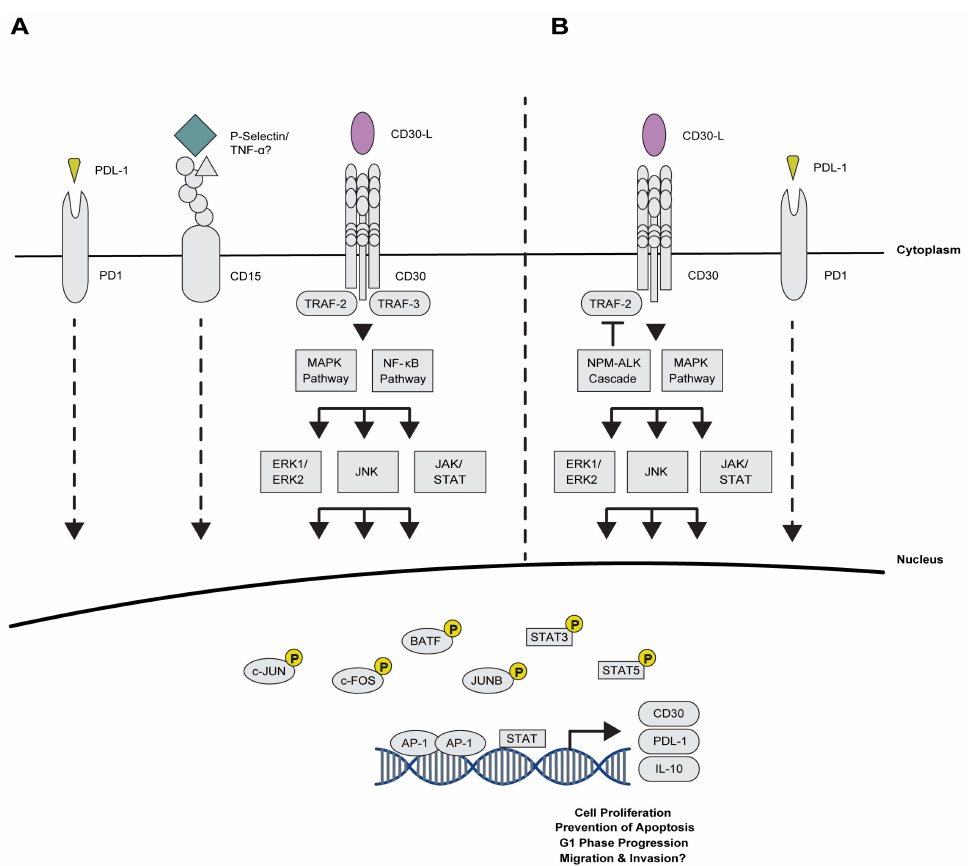
Figure 3. The intricate relationship between CD30 and AP-1 in Classical Hodgkin Lymphoma (CHL) and Anaplastic Large Cell Lymphoma (ALCL). ( A ) Cell surface protein signalling involved in CHL. In CHL, the PD-L1 enhancer binds AP-1 TFs resulting in an increase in PD-L1 promoter activity. Similarly, binding of P-Selectin (green) to CD15 (Lewis X) induces the translocation of c-JUN into the nucleus and an increase in AP-1 DNA binding activity. CD30 activation, mediated via CD30-ligand (CD30-L) (purple), results in the formation of a homo-trimer. The receptor, which lacks a kinase domain, recruits TNFR-associated factors (TRAF), which activate NF- κ B and MAPK/ERK downstream signalling pathways. The activation of NF- κ B and MAPK/ERK results